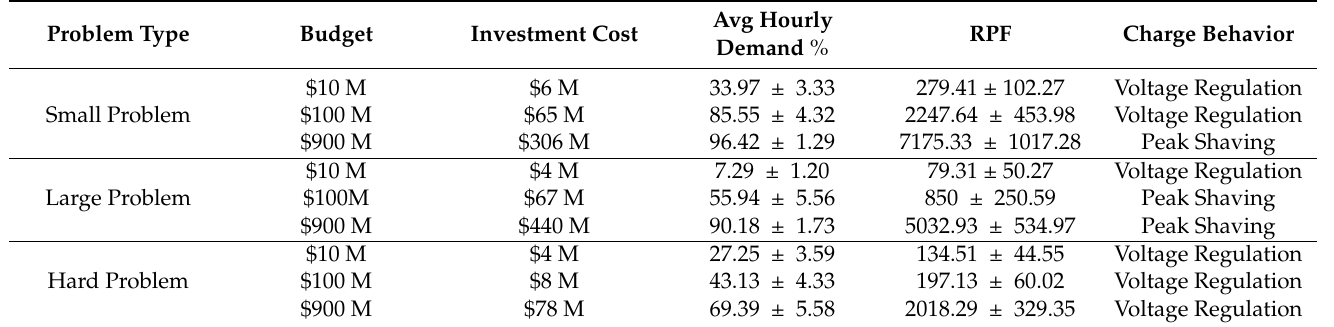
Table 4. Small (best case), large (intermediate case), and hard (worst case) problem results. Problem